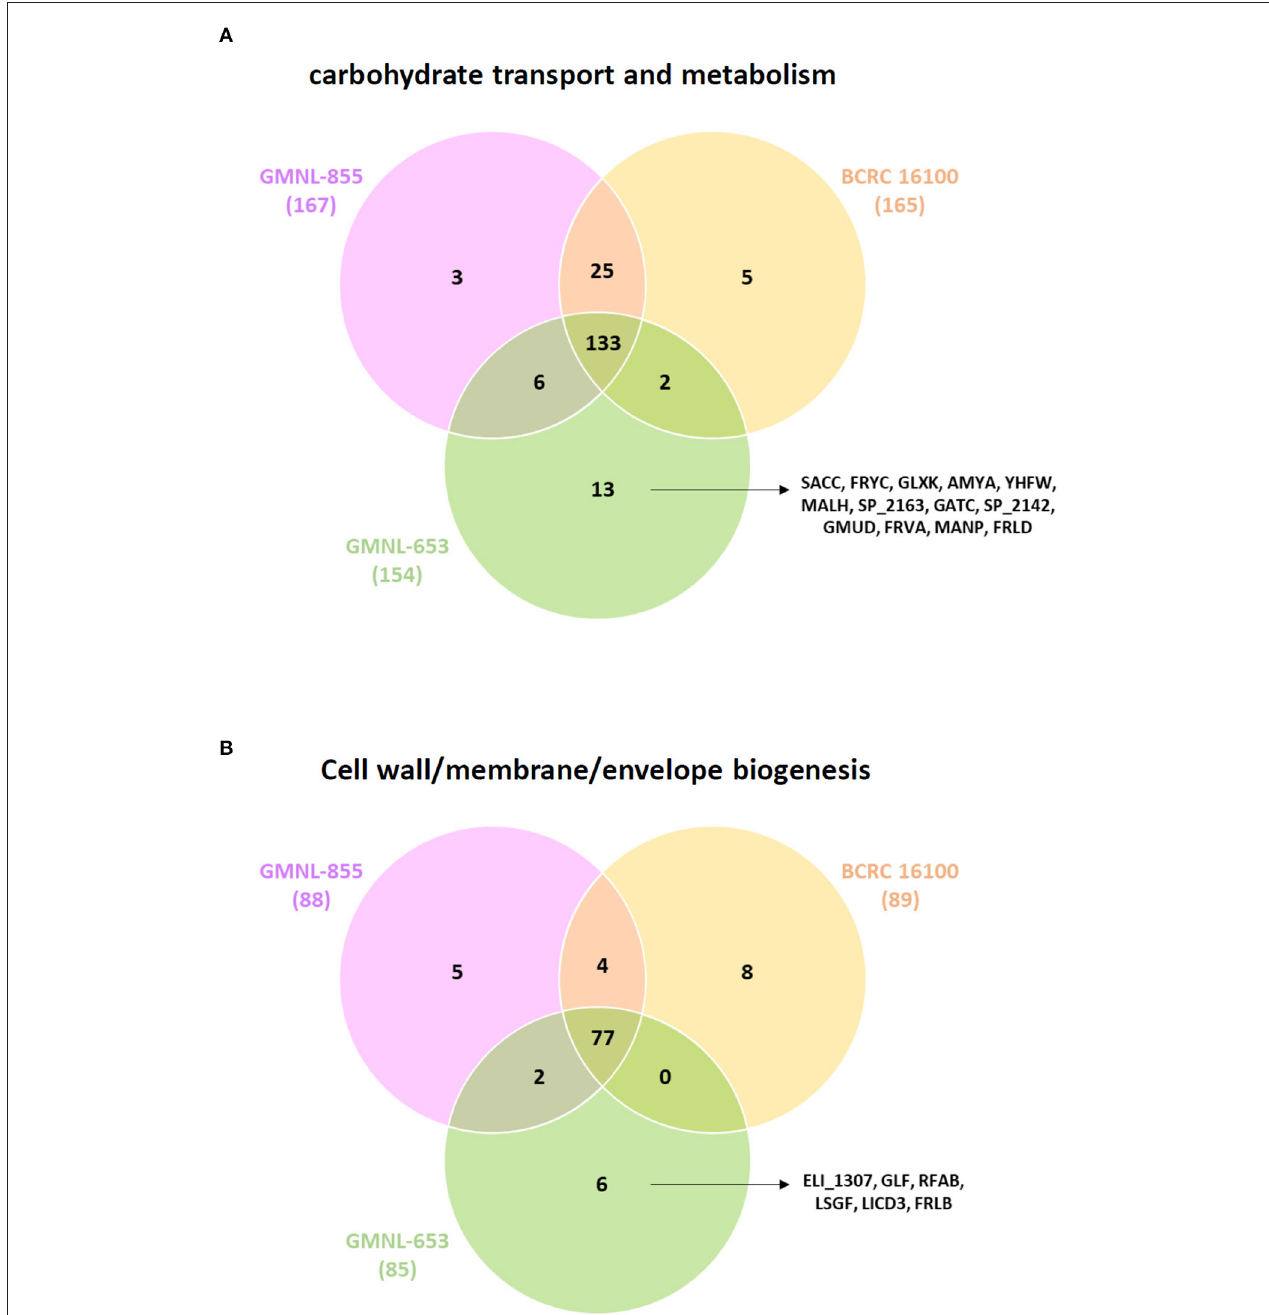
FIGURE 9 | Comparison of the genes related to (A) carbohydrate transport and metabolism and (B) cell wall/membrane/envelope biogenesis among the three L. paracasei strains.